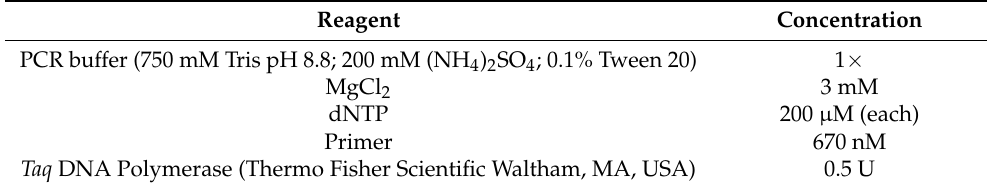
Table 1. Composition and concentrations of reagents used during ISSR analysis.